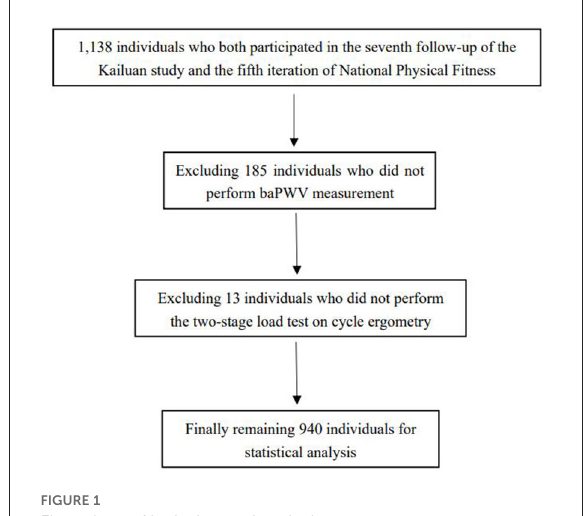
FIGURE1 Flow chart of inclusion and